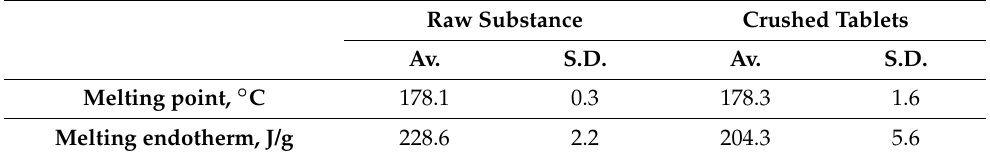
Table 2. Melting point and melting endotherm of raw substance and crushed tablets ( n = 3).